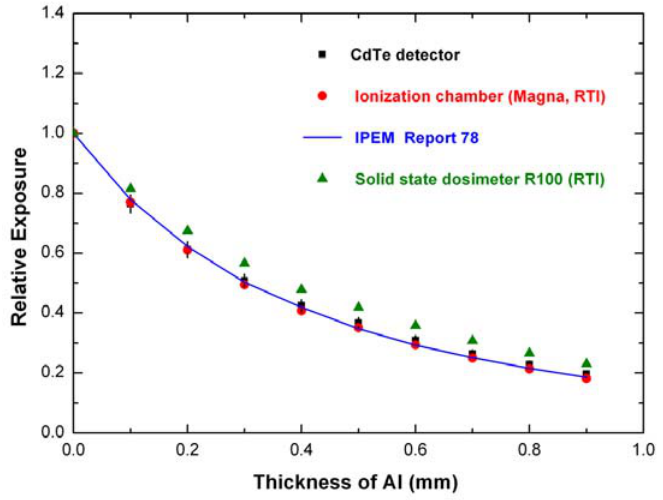
Figure 7. Attenuation curves obtained from measured and simulated spectra and from direct exposure measurements (ionization chamber and solid state detector). The tube settings were: 28 kV and 20